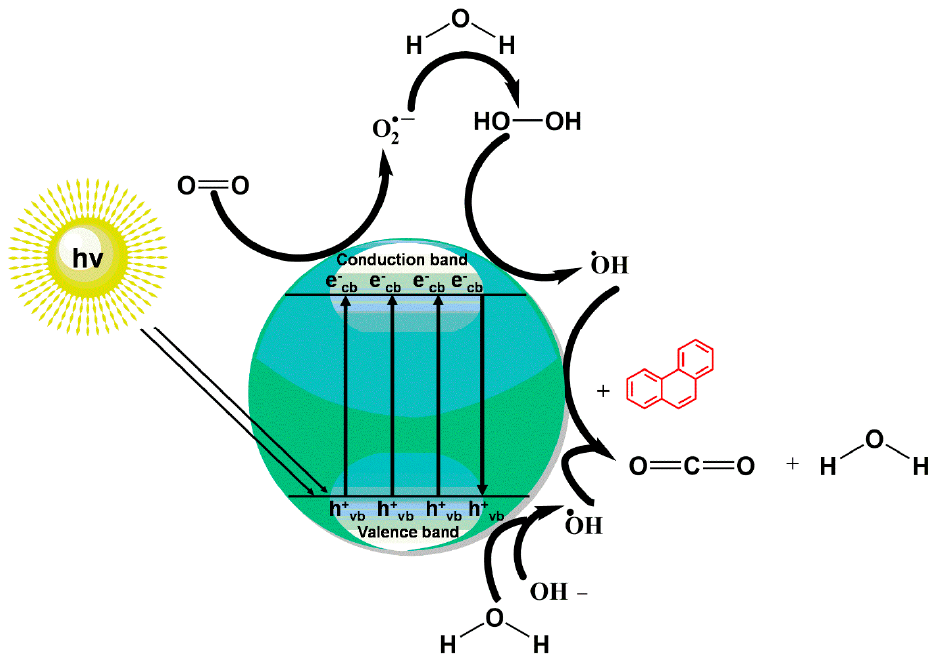
Figure 3. The implemented degradation of phenanthrene by photocatalysis intervened by photo- generated OH ● radical and hole.